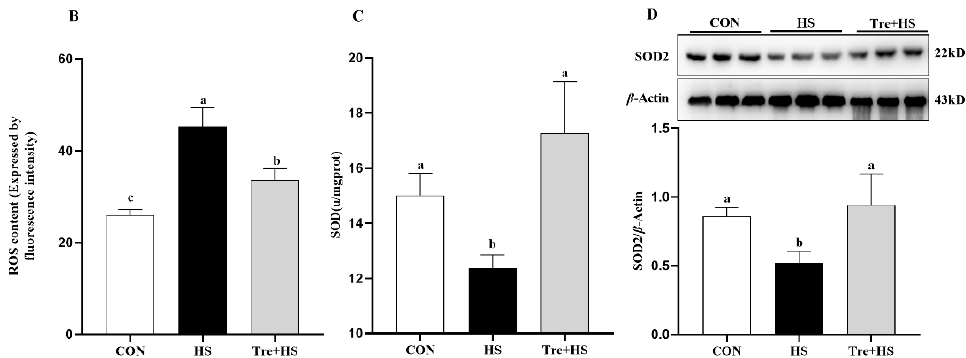
Figure 2. Effects of trehalose on cellular ROS level, SOD activity, SOD2 expression level in heat-stressed IPEC-J2 cells. IPEC-J2 cells were cultured at 37 °C until the end of the experiment (control, CON); exposed to heat stress for 2 h (43 °C, HS); or pretreated with 10 mM trehalose at 37 °C for 4 h prior to heat stress exposure for 2 h (Tre + HS). Cellular ROS accumulation was measured by the DCFH-DA fluorescence analysis ( A , B ). SOD2 activity ( C ). Expression level of SOD2 tested by Western blot ( D ). SOD2: superoxide dismutase 2. Data are shown as mean ± SD (n = 3). Means for variables that do not share a common letter differ significantly ( p < 0.05).